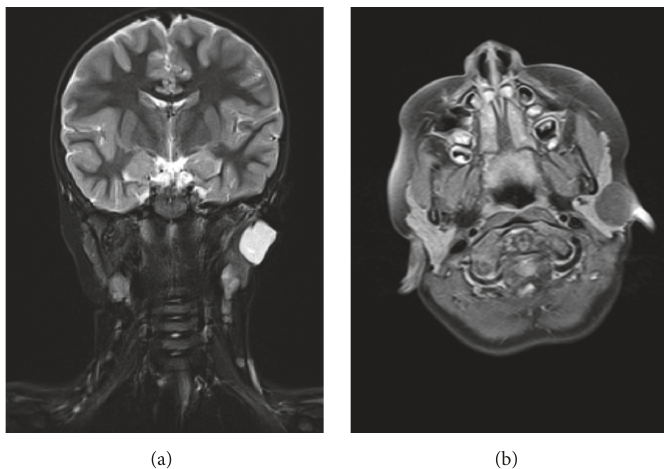
Figure 2: (a) Coronal MRI scan showing a signal enrichment in T2 weighting in the left parotid gland. (b) T1 weighted axial MRI scan showing a hypointensity of the same structure.